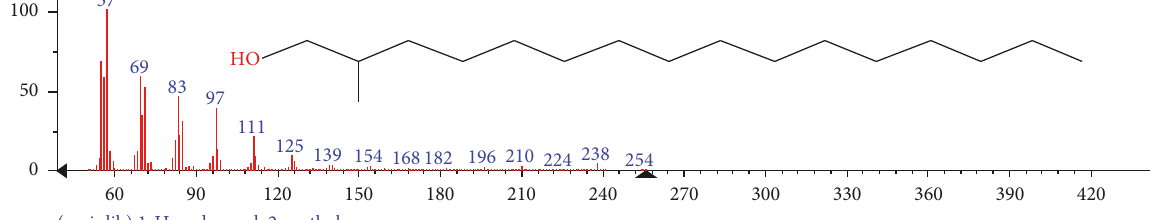
2-methyl-60 90 (mainlib) 1-Hexadecanol, Figure 57: Mass spectrum of compound 1-hexadecanol, 2-methyl- of whole plant hexane fraction of Achillea wilhelmsii (WHFAW).